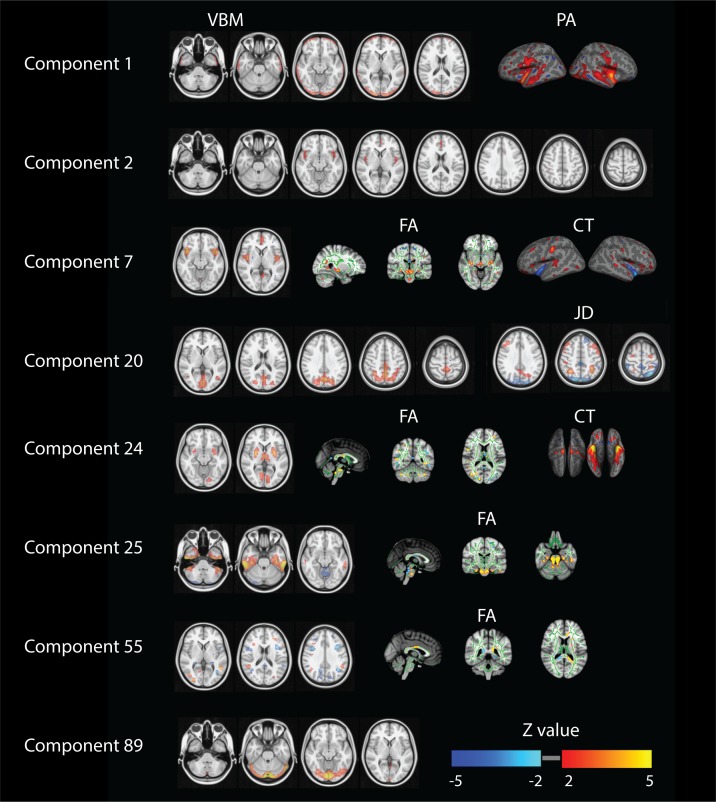
Summary of relevant modalities spatial maps associated with the components indexed in the most left column.For component one we show spatial maps for VBM and PA, and for components number 2 and 89 just VBM. For numbers 7 and 24 we present VBM, FA and CT. For number 20 we show VBM and JD and finally for numbers 25, 29 and 55 we present VBM and FA.